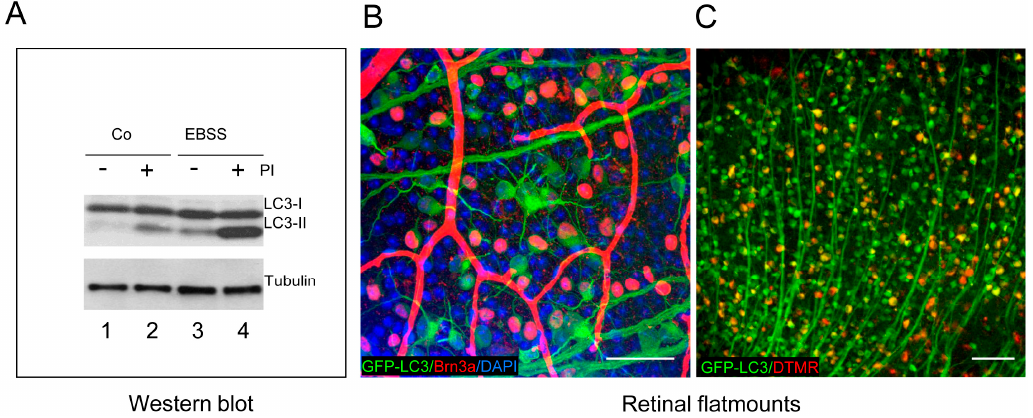
Figure 3. Assessment of autophagic flux by western blot and immunostaining of retinal flatmounts. ( A ) E13.5 embryonic retinas are incubated with or without EBSS to induce autophagy and incubated in the presence (+) or absence ( − ) of PI (ammonium chloride and leupeptin). Note the differential electrophoretic mobility of the non-lipidated (LC3-I) and lipidated (LC3-II) LC3 bands; ( B ) assessment of autophagy in GFP-LC3 retinal flatmounts (in green) from adult mouse stained with the RGC marker Brn3a (Millipore MAB1585, in red). Nuclei are stained with DAPI (in blue). Note the non-specific binding of the secondary antibody (in red) to the retinal vessels; and ( C ) retrograde labelling of RGCs (in red) in the GFP-LC3 mouse (adult, in green) by injection of the RGC-specific dye DTMR (Dextran tetramethylrhodamine, Molecular Probes, in red). Scale bars 50 μ m.